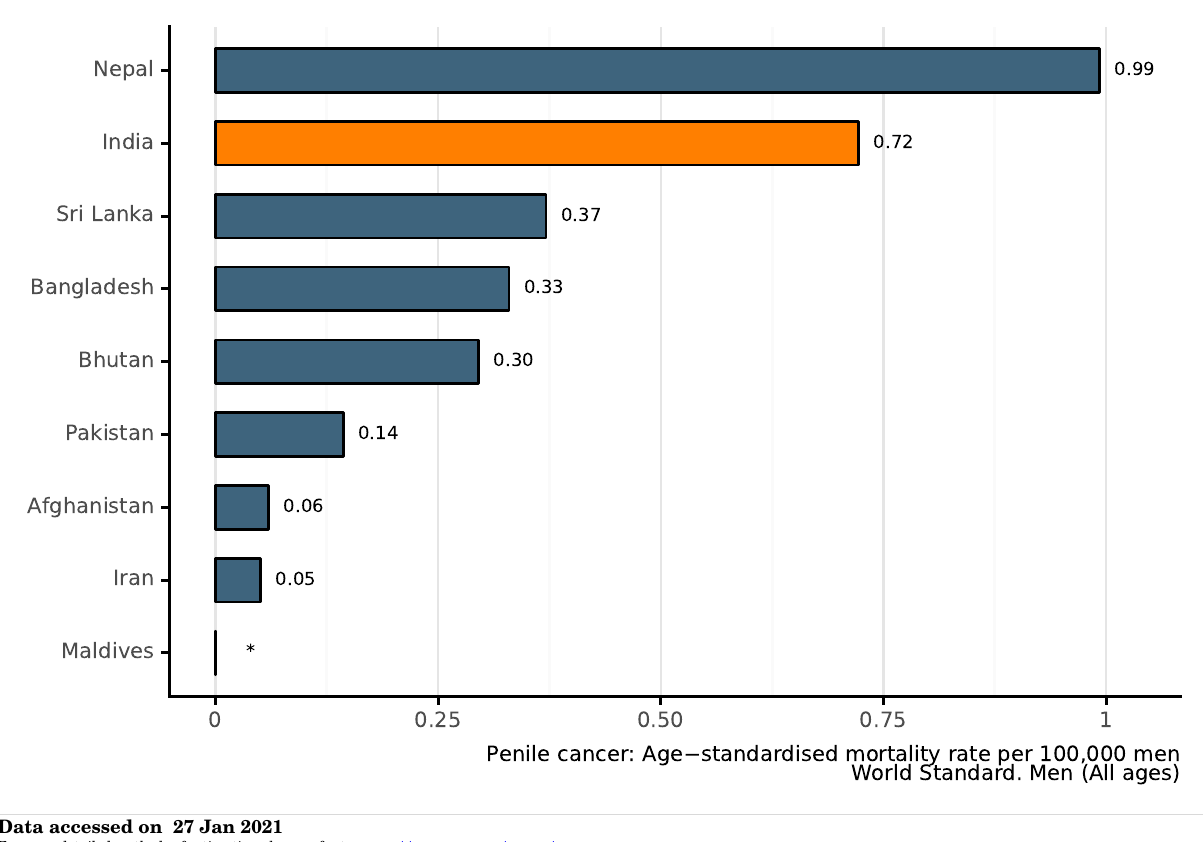
Figure 119: Age-standardised mortality rates of penile cancer of India (estimates for 2020)